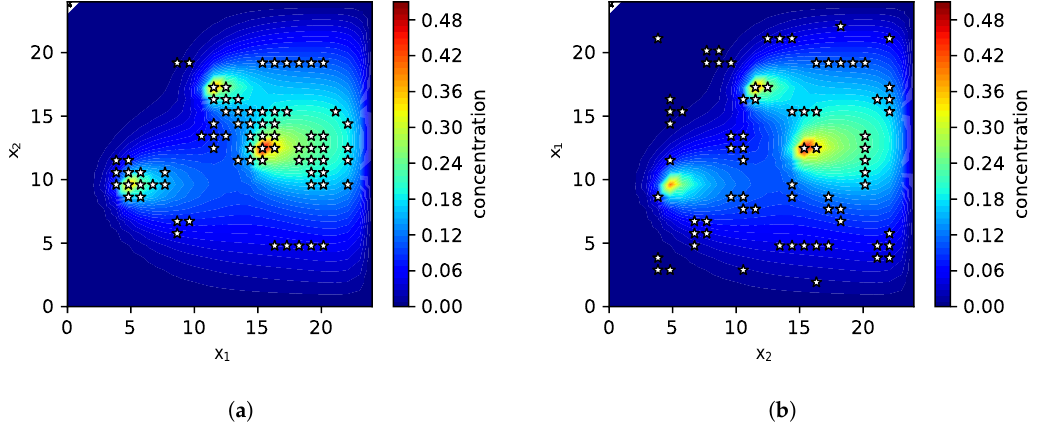
Figure 4. The two plots show as an example the sampling pattern for the strategy with a sparsity prior in ( a ) and without the use of a sparsity prior in ( b ). The parameters were chosen as τ m = 10 5 , τ s = 10 4 . The white stars indicate the measurement locations. The color map represents the ground truth gas concentration field. The sources are obviously located at the locations with the highest concentration. In both cases the scene is a snapshot after 15